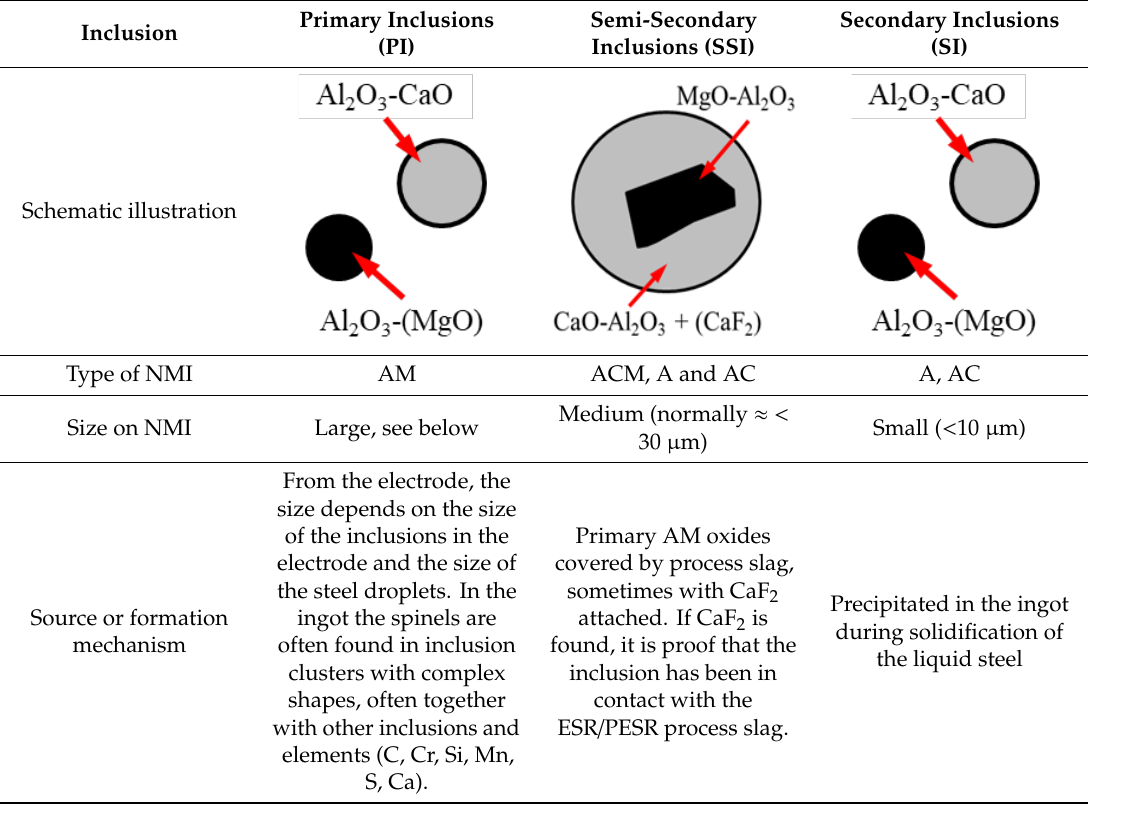
Table 2. Characterization and a general schematic of the three described inclusion types.